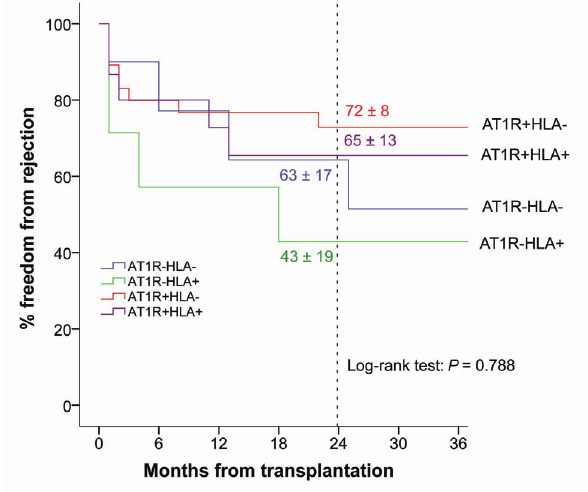
Fig. 4. Freedom from rejection of transplanted patients strati- fied according the presence of anti-AT1R antibodies and anti- HLA